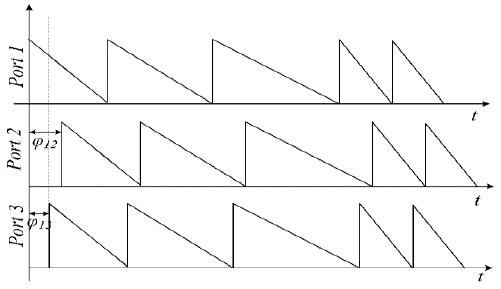
Figure 12. Synchronously chaotic modulation.